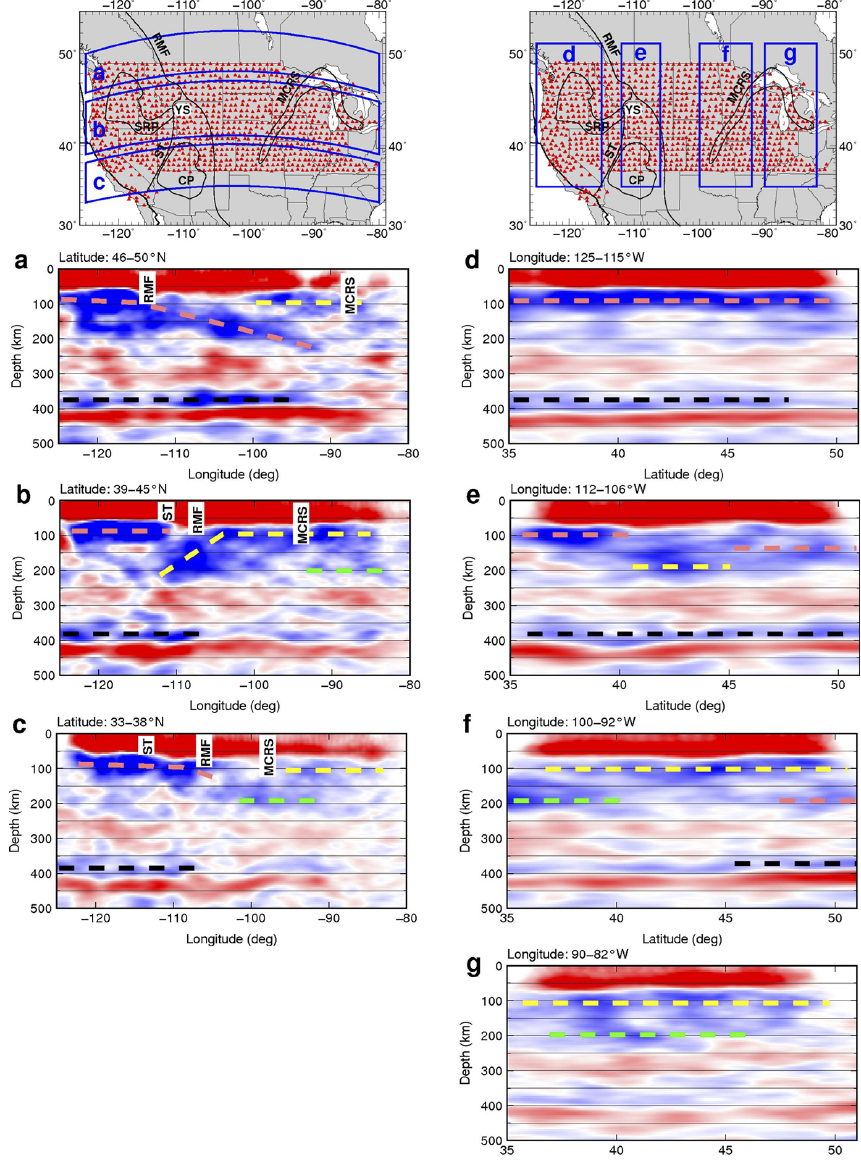
Figure 9. The same data and same correlation marks as in Fig. 8 but summed along broader south–north and west–east profiles. The profile width and orientation is shown in the location maps at the top of the figure. Region (a) (northernmost west–east profile) does not have any stations in Canada. However, due to the shallow incidence angle of the S-receiver functions, the mantle below southern Canada is also sampled by events from the northwest. The westernmost south–north profile (d) shows only the western LAB in the mantle lithosphere. In profile (e) we see at the southern and northern ends the western LAB, and in the central part the deep MLD. In profile (f) we see the cratonic MLD (yellow), the cratonic LAB (green) and in the north the deep western LAB (magenta). In the easternmost south–north profile (g) we see the MLD and weakly the cratonic LAB. See Fig. 1 for explanation of the abbreviations of tectonic